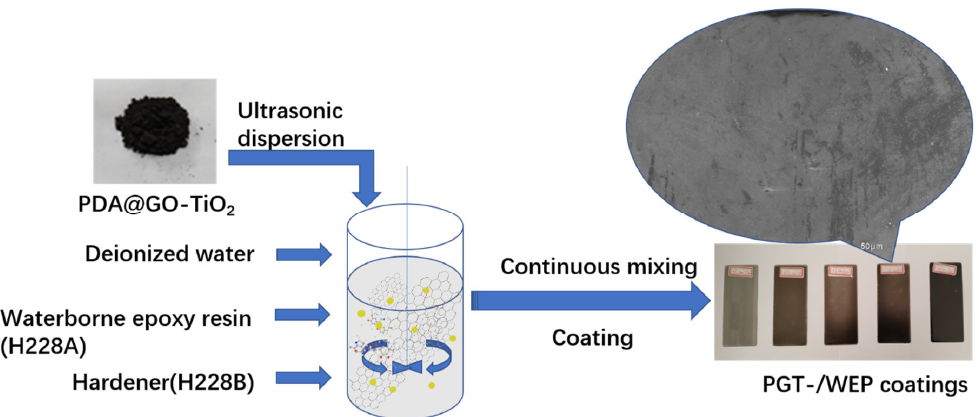
Figure 2. Chart of preparation of composite coating.